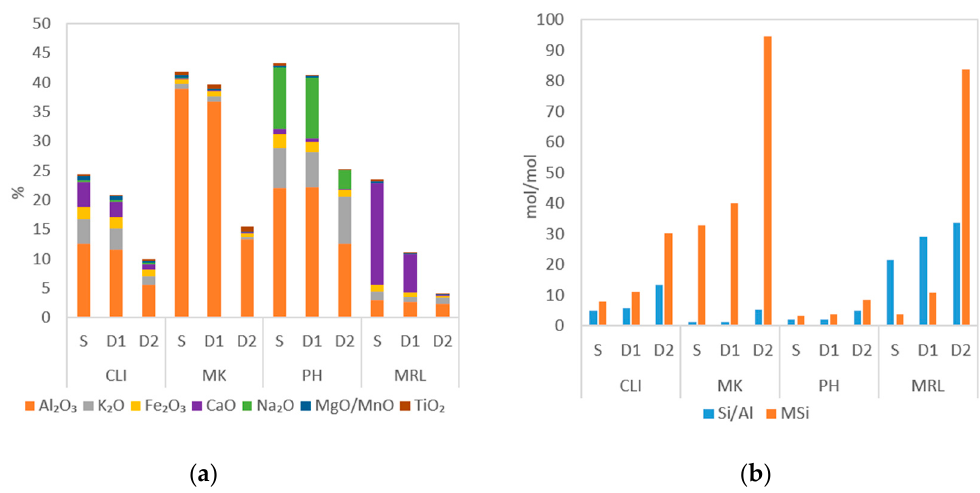
Figure 1. Chemical composition (silicon is up to 100%) ( a ) and Si/Al ratio and M Si parameter ( b ) of clinoptilolite (CLI), metakaolin (MK), phonolite (PH) and marlstone (MRL) determined as untreated (S), leached using 0.1 M HCl (D1) and leached using 3 M HCl (D2).